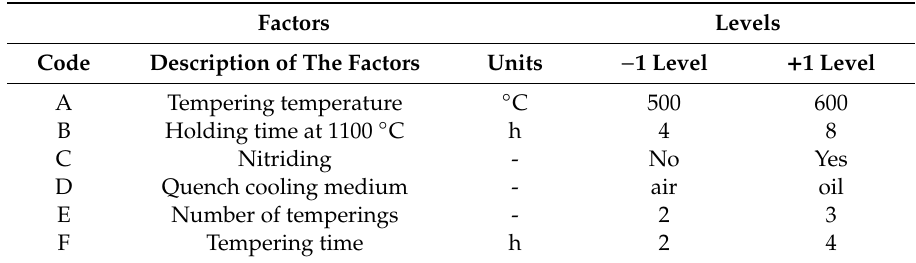
Table 2. Factors and levels. Heat-up rates of about 15 ◦ C per minute and cool down rates on quenching in the range of 70–80 ◦ C per second were used. Factors Levels Code Description of The Factors Units − 1 Level + 1 Level A Tempering temperature ◦ C 500 600 B Holding time at 1100 ◦ C h 4 8 C Nitriding - No Yes D Quench cooling medium - air oil E Number of temperings - 3 Tempering